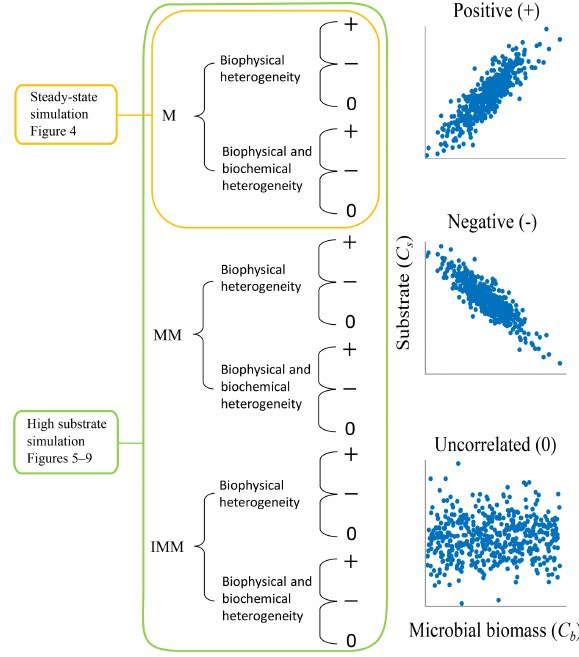
Figure 3. Two scenarios were implemented based on the initial spa- tial distribution of substrate and microbial C. In scenario 1, substrate and microbial C are perturbed around the steady state of the mi- croscale differential equations, and simulations are only carried out with the multiplicative (M) kinetics. In scenario 2, substrate and microbial C are perturbed to values larger than the steady state, and simulations are conducted for multiplicative (M), Michaelis– Menten (MM), and inverse Michaelis–Menten (IMM) kinetics. For each scenario and type of heterogeneity, three different initial dis- tributions of substrate and microbial biomass are considered to be representative of microscale heterogeneities (positively correlated ( + ), negatively correlated ( − ), and uncorrelated (0) fields of sub- strate and microbial